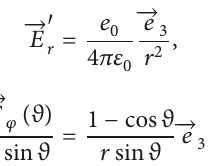
Figure 5: Stereographic view with parallel eyes at a fibre neighbour- hood. (a) Fibre F on a torus in R 3 . Dreibeins of red tangential vectors and blue and cyan tangential vectors are drawn at three positions. (b) Gauß map C F of F with red radial vector and blue and cyan tangential vectors at the corresponding three